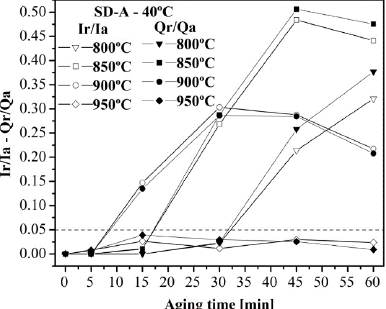
Figure 5. I + 0.01 M KSCN + 0.50 M NaCl solution test at 40 °C.